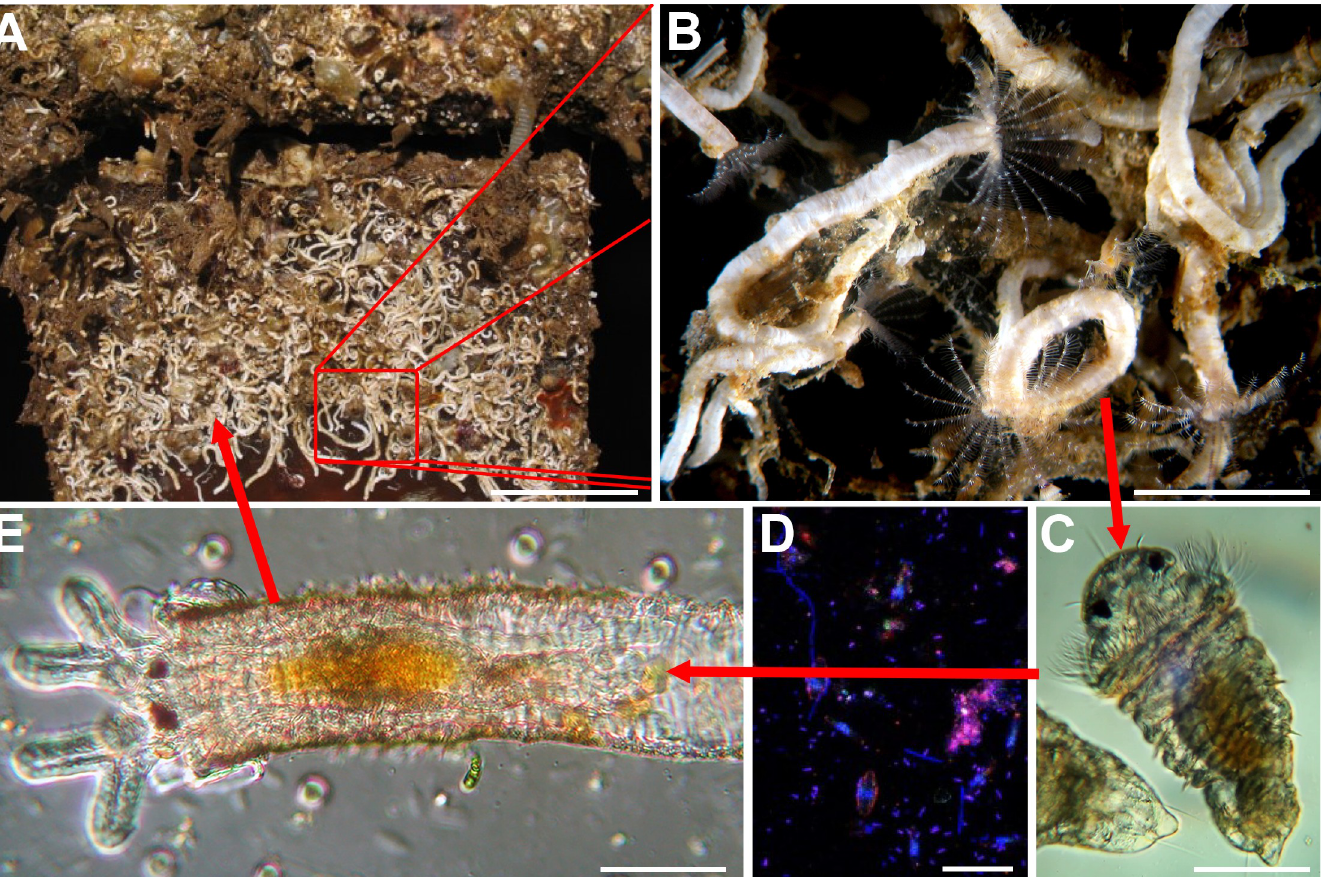
Fig 1. The life cycle of H . elegans . (A) Mature population of H . elegans . (B) Close up of an adult H . elegans . (C) Competent larva of H . elegans . (D) Biofilm bacterial surface required for larval metamorphosis. (E) Early juvenile of H . elegans . Scale bars: A, 5 cm; B, 1 cm; C, 50 μ m; D, 5 μ m; E, 50 μ m.